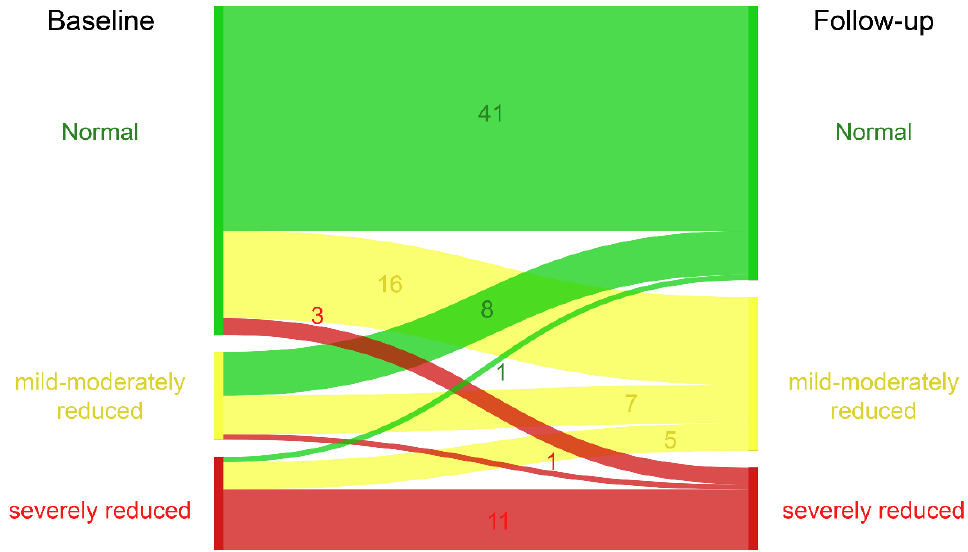
Figure 2. Sankey diagram of systolic systemic ventricular function at baseline and follow-up. During follow-up, 19 patients underwent cardiac surgery, which in the majority of cases was tricuspid valve surgery (11 replacements, four reconstructions; Figure 3).